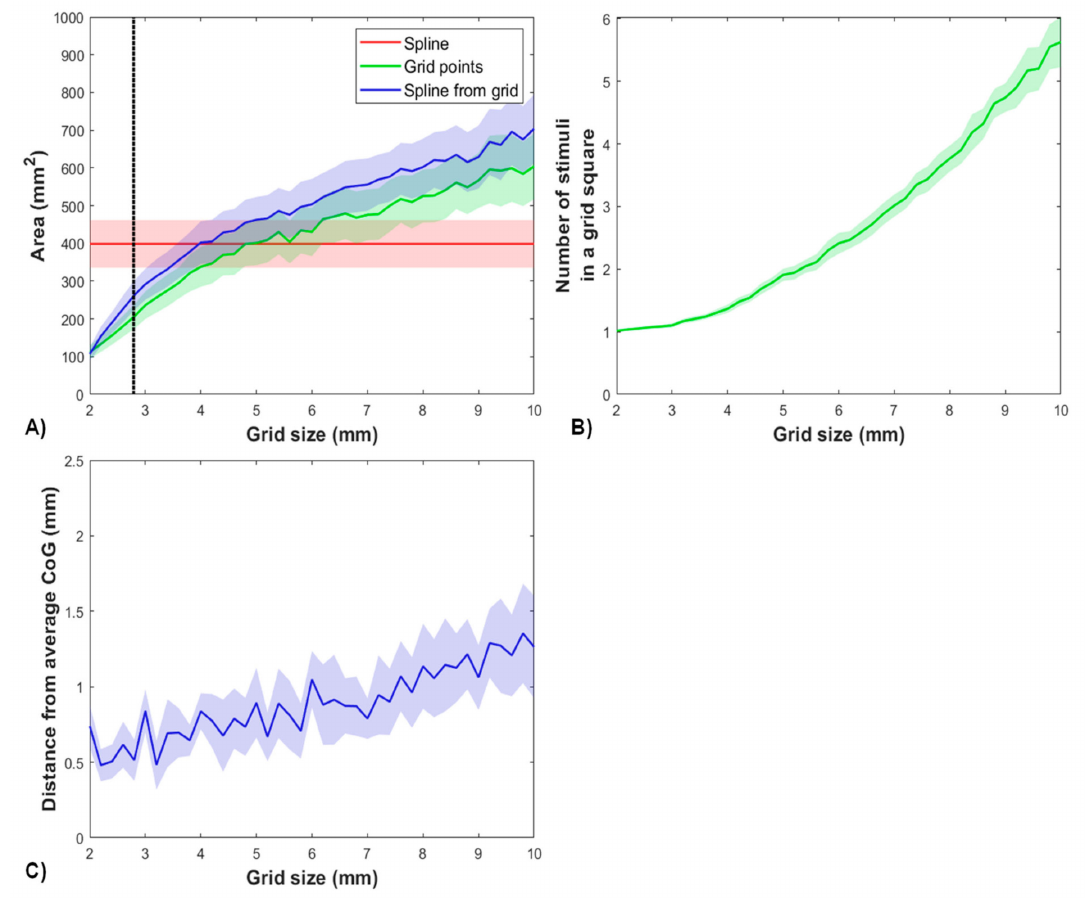
Figure 9. ( A ) The effect of grid size on the resulting motor areas with different methods of calculation. As a comparison, there is the area calculated with the spline interpolation ( red ), which is independent of the grid size, but is instead dependent on the local spacing of the stimuli. The area calculated from active grid squares is presented in green and, for ease of comparison, the spline interpolation area calculated from the active grid sites is shown in blue . The shaded areas indicate the 95% confidence interval within the study population, which was 24 mapping experiments at 110% of rMT. ( B ) The average number of stimuli falling within each grid square is shown as a function of grid size, with the shaded area indicating the 95% confidence interval within the study population. ( C ) The effect of grid size on the CoG location is shown, with the shaded area indicating the 95% confidence interval within the study